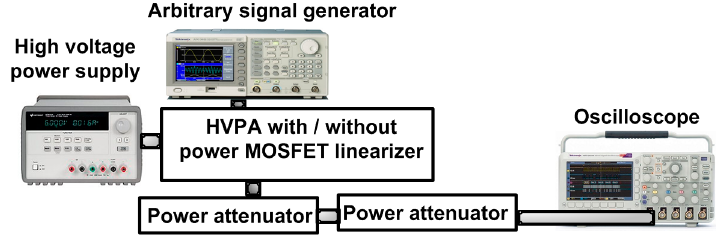
Figure 5. The measurement setup for HVPA with and without the power MOSFET linearizer.